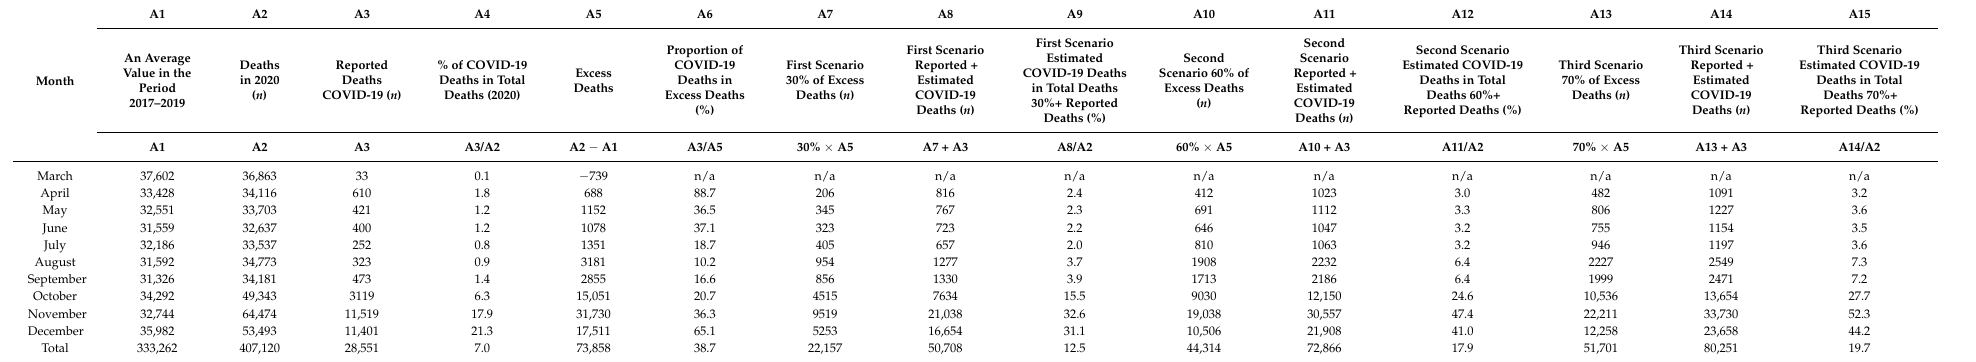
Table 4. Total and COVID-19 deaths in Poland in 2020.